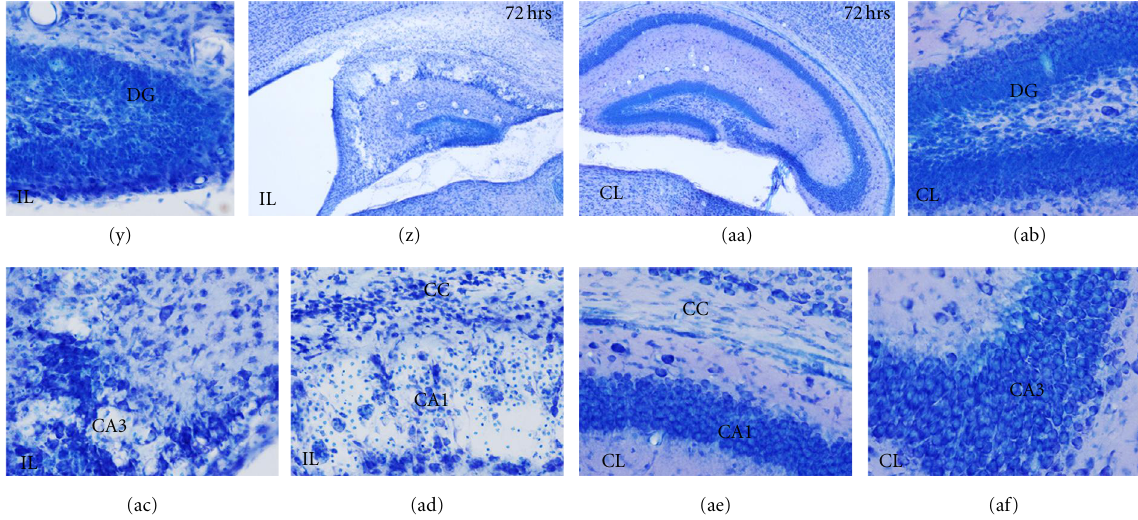
Figure 2: Nissl staining showing hypoxia/ischemia (H/I) e ff ects on the hippocampus and corpus callosum of the contralateral (CL) (right side of the panel), and ipsilateral hemisphere (IL) (left side of the panel), from 3 to 72 hours (hrs) after hypoxia. At 3hrs (a–h), layer disruption is seen in ipsilateral CA3 (e) and increased cellularity in the ipsilateral corpus callosum (f). At 24hrs (i–p) neuronal degeneration is widespread in hippocampus (i, j, m, and n). At 48 hrs (q–x) and 72hrs (y–af), hippocampal atrophy (compare r to s, z to aa) and massive neuronal loss is seen in CA1 and CA3 (r, u, and v for 48hrs, z, ac and ad for 72hrs) although the DG is also disorganized (compare q to t, y to ab). Increased cellularity in the corpus callosum is also seen (v and ad). Scale bars (low magnifications: b, c, j, k, r, s, z, aa) = 100 μ m; scale bar in all other micrographs = 25 μ m. CA1: cornu ammonis 1; CA3: cornu ammonis 3; CC: corpus callosum; DG: Dentate